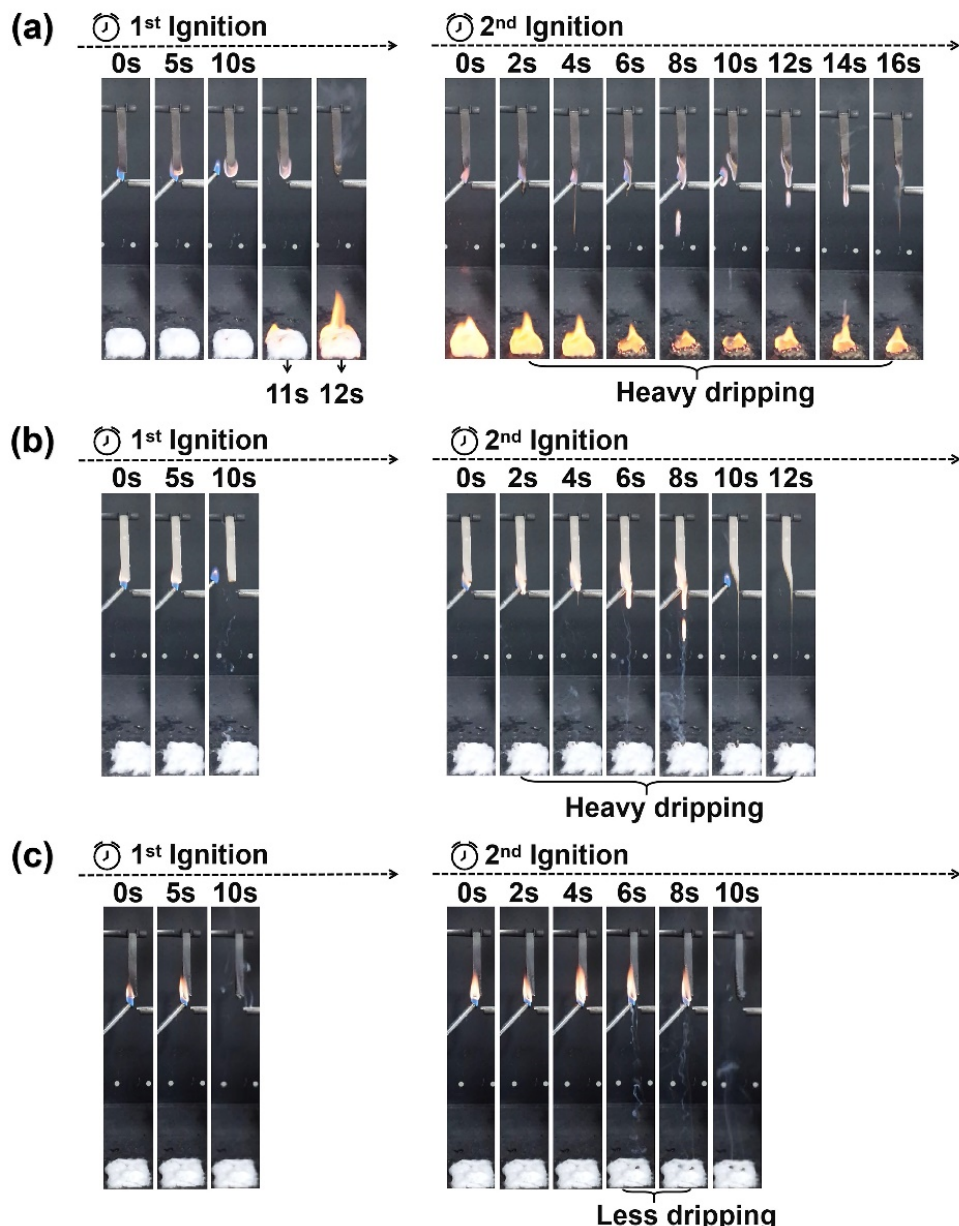
Figure 2. The video screenshots of ( a ) PLA/B15, ( b ) PLA/M5, and ( c ) PLA/M5B15 during UL-94 tests. Table 3. The UL-94 test results of PLA and PLA composites. Samples 1